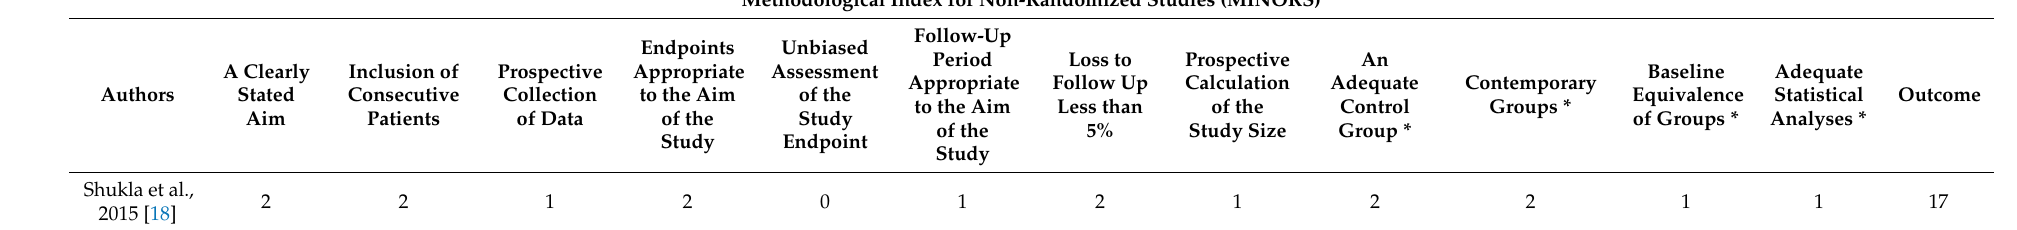
Table 3. Methodological index for non-randomized studies (MINORS) to assess the methodological quality and risk of bias of the included observational studies. Items are scored 0 (not reported), 1 (reported but inadequate) or 2 (reported and adequate), with the global ideal score being 16 for non-comparative studies and 24 for comparative